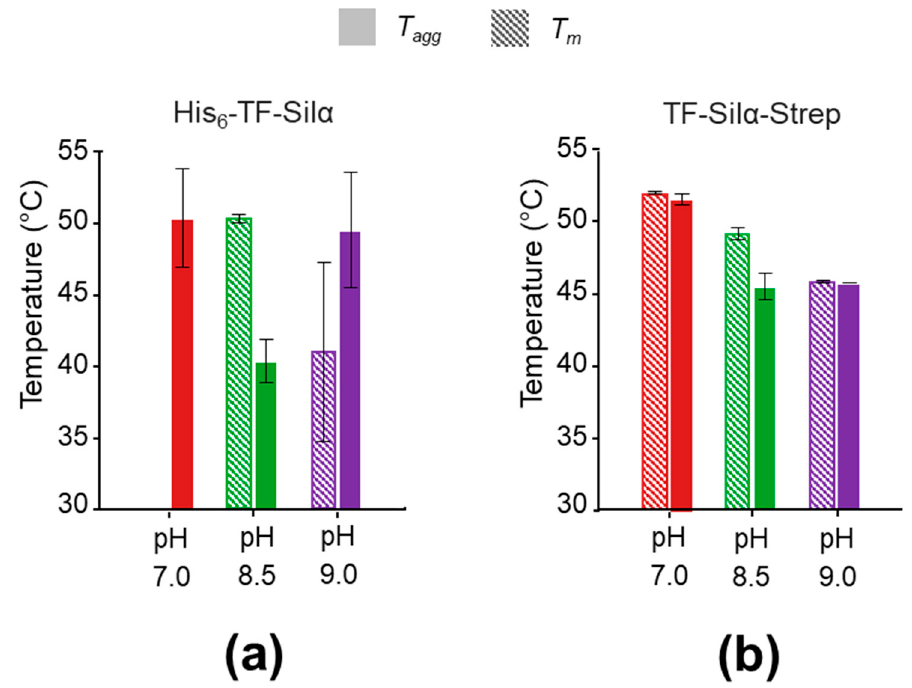
Figure 6. Graphs showing the apparent T m (hashed bars) and T agg (solid bars) calculated from SLS and fluorescence data for ( a ) His 6 -TF-Sil α ; ( b ) TF-Sil α -Strep. Error bars shown are based on the standard deviation of two replicate protein samples.